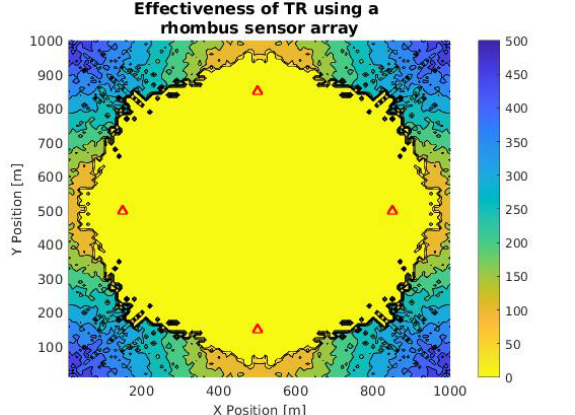
Figure 6. Contour plot of TR calculation accuracy in a rhombus-shaped array in an area of 1 km 2 for a landing ship signal. Red triangles are sensor positions and the color scale is a function of the difference between the expected and calculated